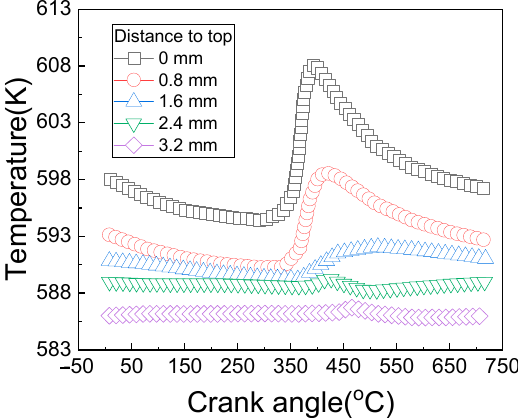
Figure 2. Temperature fluctuations at different depths from the piston top.